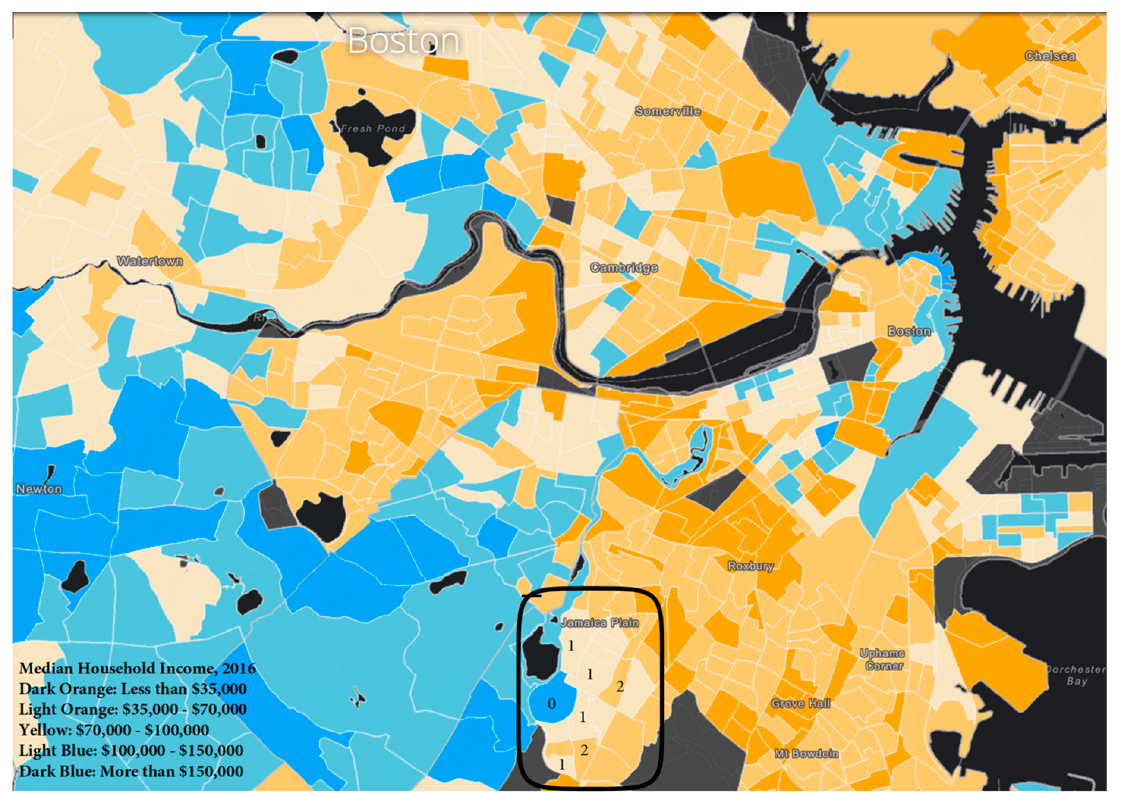
Figure 3. Map of Boston area by income. Source: Wealth Divides (Storymaps by ESRI) Numbers in Jamaica Plain inset indicate number of yoga studios.